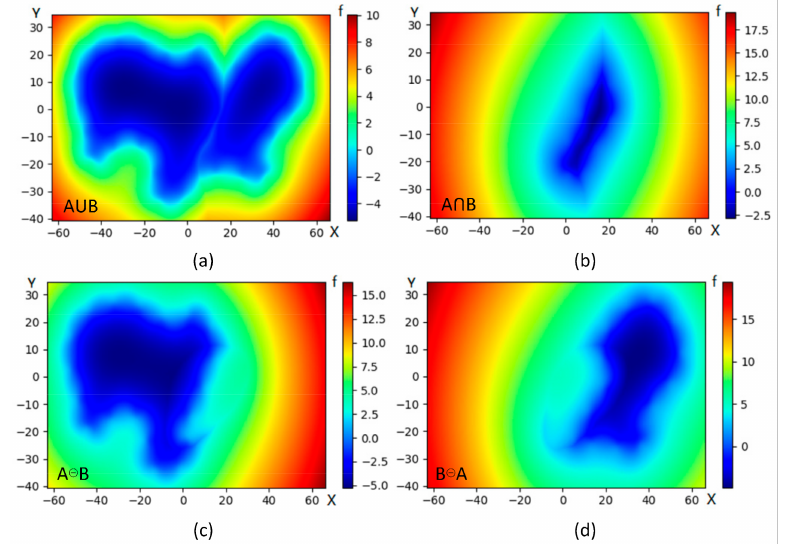
Figure 2. Combination operations of two fields A and B: ( a ) union operation A ∪ B ; ( b ) intersection operation A ∩ B ; ( c ) difference operation A (cid:127) B ; ( d ) difference operation B (cid:127) A . The range of signed distance values corresponds to the color